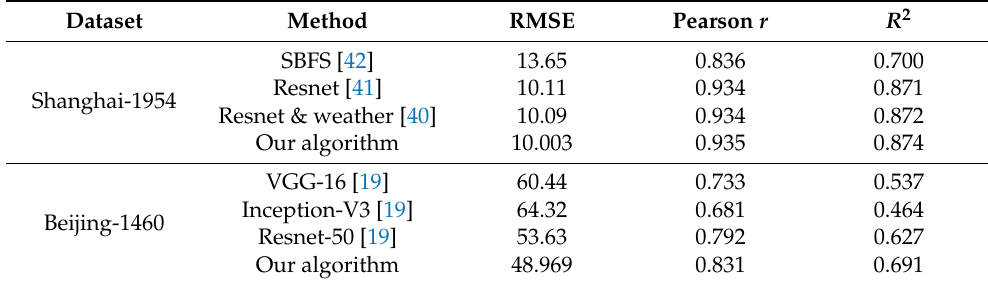
Table 3. Root-mean-squared error, mean absolute error, and Pearson correlation of PM 2.5 estimates based on the PhotoPM-daytime